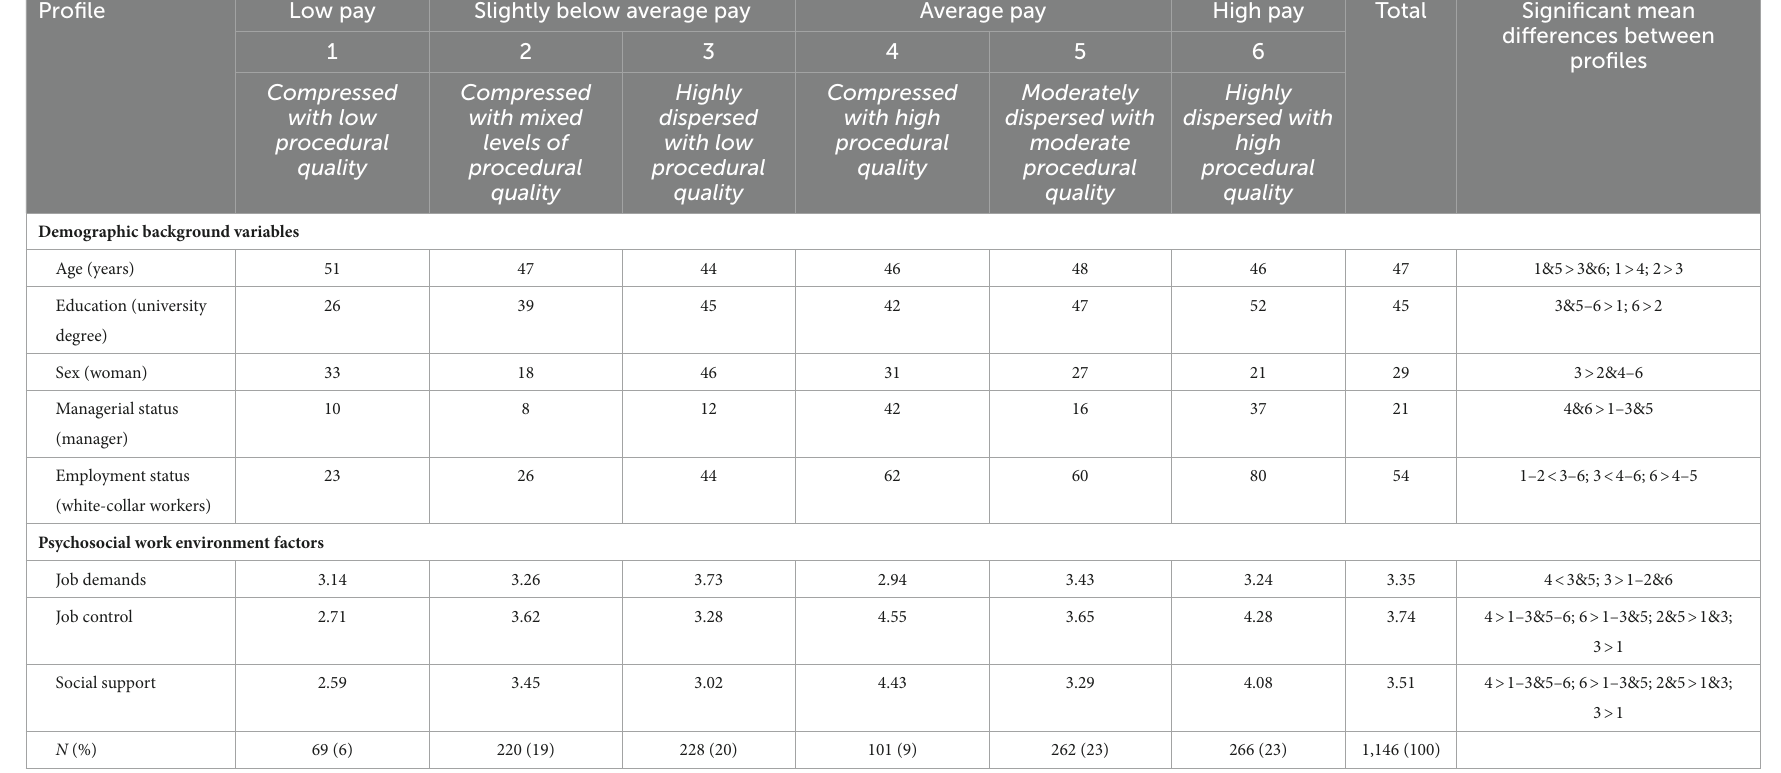
TABLE 5 Wald χ 2 difference tests between the six latent profiles for the demographic background variables and psychosocial work environment factors. Profile